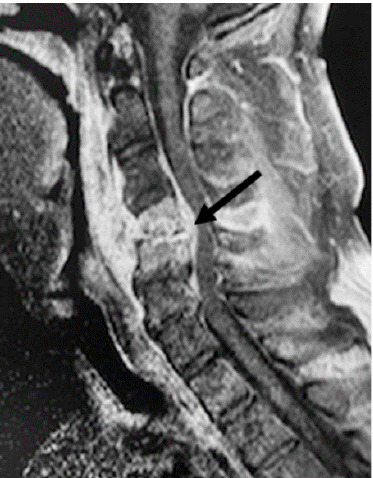
Image 2. Magnetic resonance imaging of sagittal plane of cervical spine showing fourth and fifth cervical osteomyelitis (arrow) upon admission.